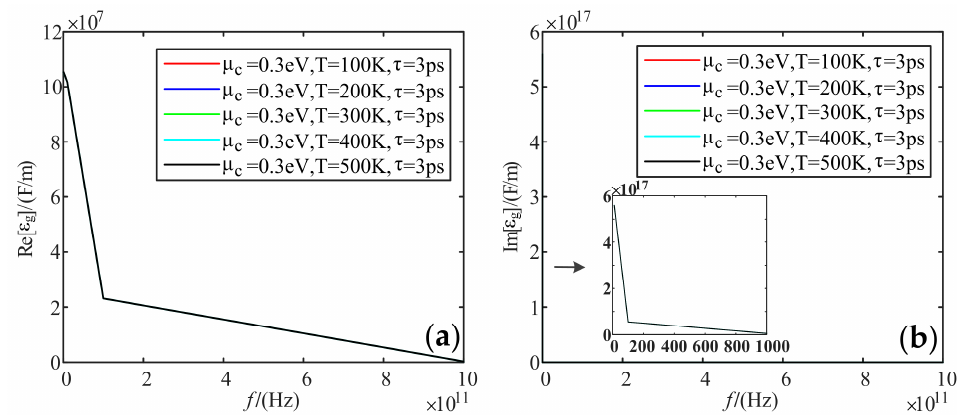
Figure 8. Variation curve of graphene dielectric constant with frequency at different temperatures: ( a ) real part; ( b ) imaginary part.